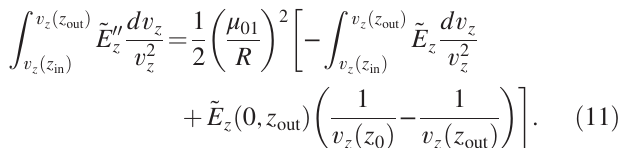
Fig. 16. A comparison of the emittance variation along the gun with a flat and concave cathode is presented in Fig. 17.